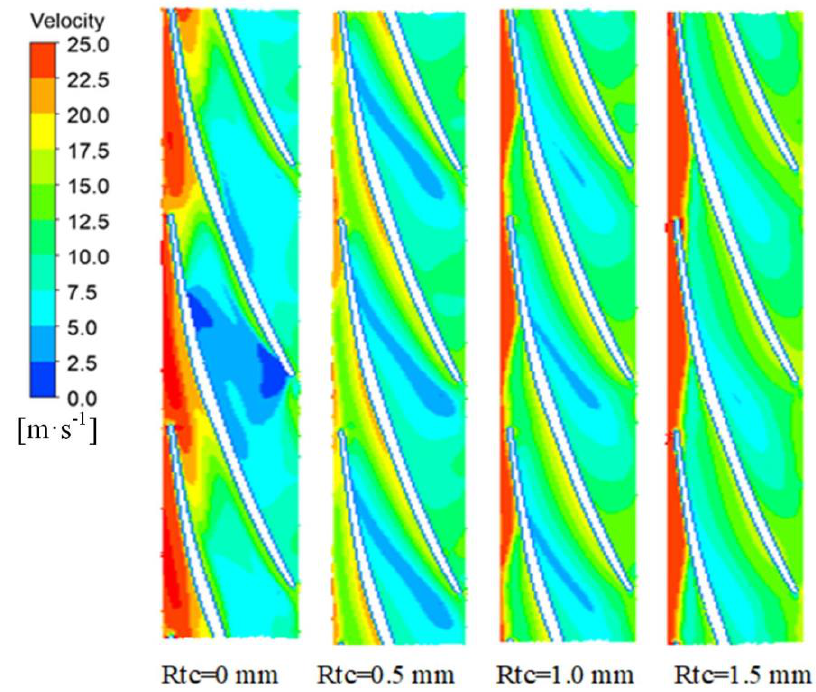
Figure 11. Velocity at the radial coefficient r * = 0.9.